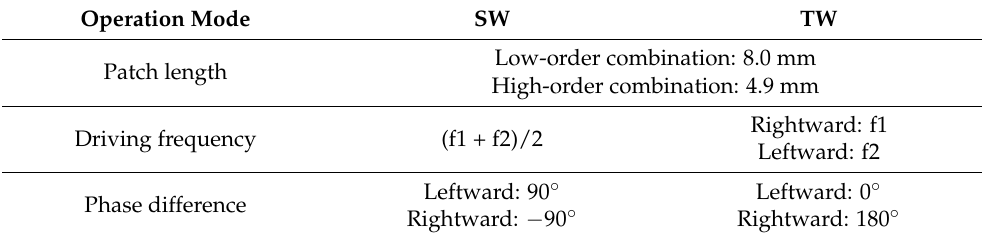
Table 2. Summary of the parameters to consider for the operation mode of the TW- and the SW- based approaches.